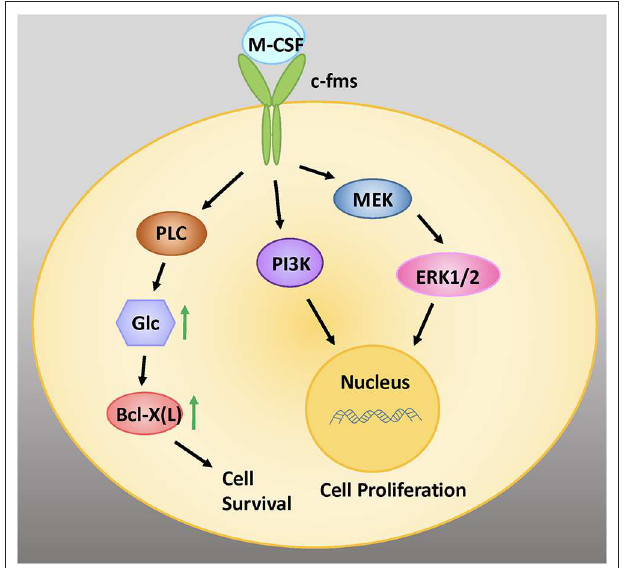
FIGURE 1 | M-CSF signaling is critical for the survival, proliferation, and differentiation of early osteoclastic precursor cells. M-CSF binds to the cell surface receptor c-fms, a tyrosine kinase receptor. Intracellular signaling via the MEK/ERK and PI3 Kinase (PI3K) signaling pathways promote cell proliferation. Signaling via PLC increases intracellular glucose (glc), which increases levels of the anti-apoptotic protein Bcl-X(L), leading to cell survival. Adapted from Stanley and Chitu, Cold Spring Harb Perspect Biol , 2014